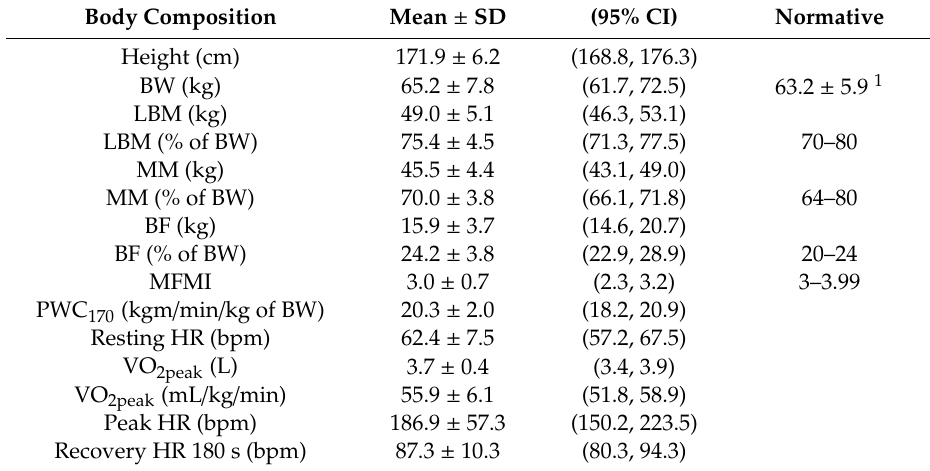
Table 2. Body composition and physical capacity (peak oxygen uptake (VO 2peak ) and physical working capacity (PWC 170 )) of deaf